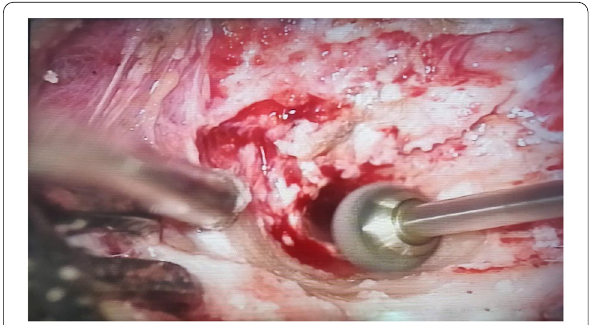
Fig. 2 Drilling along with suction and irrigation being done during canaloplasty (right ear)